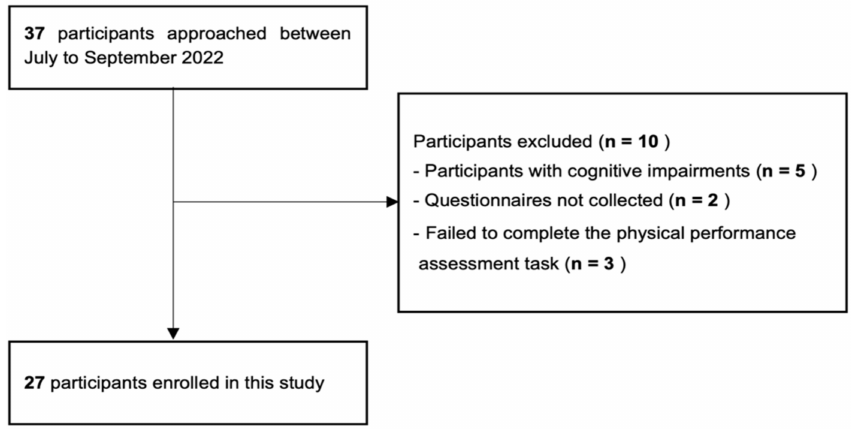
Figure 1. Flow chart of the participant selection